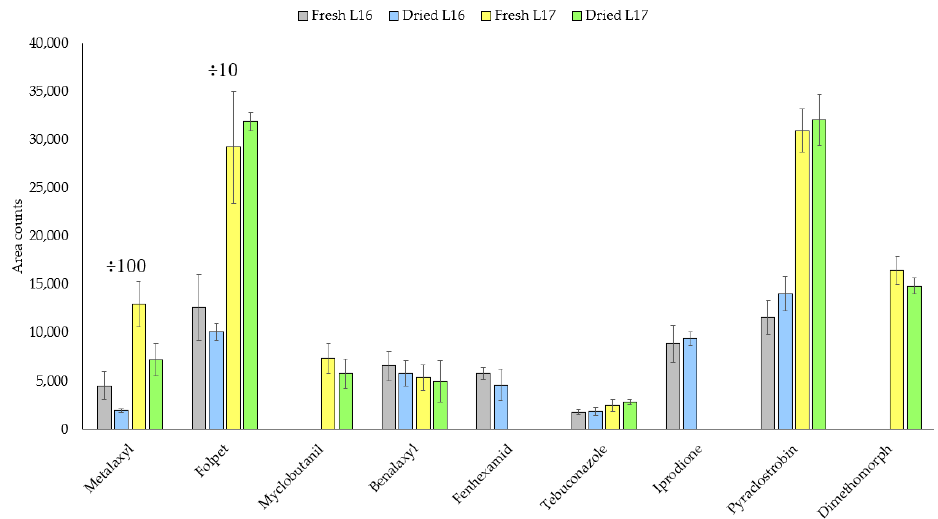
Figure 4. Fungicide responses for dried and fresh leaves in two real samples (L16 and L17). ÷100: area counts of metalaxyl divided by 100; ÷10: area counts of folpet divided by 10.